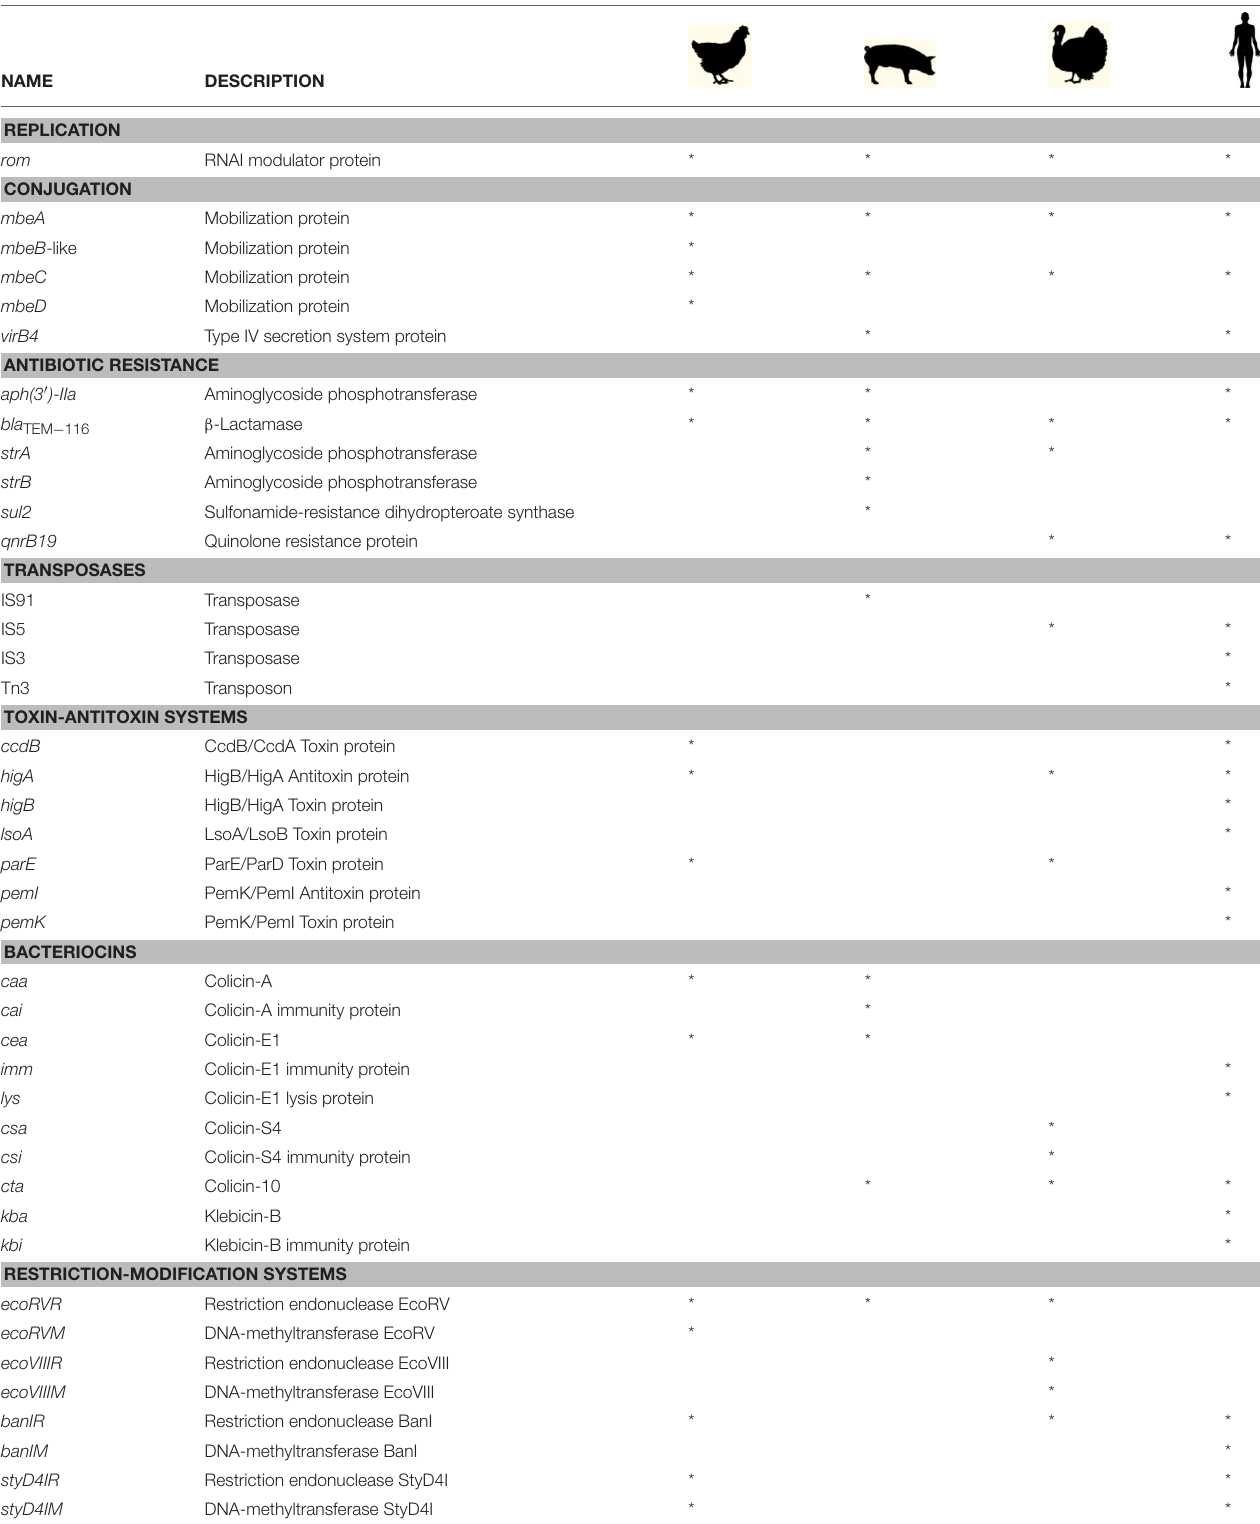
TABLE 1 | List of genes harbored by ColE1 plasmids in the fecal